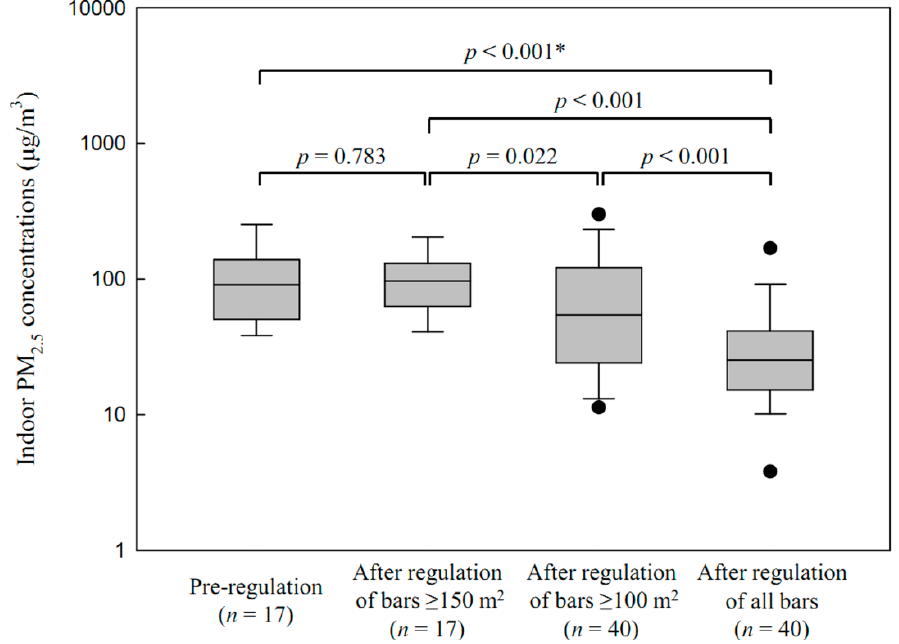
Figure 3. Distribution of indoor PM 2.5 concentrations in Seoul bars, pre-regulation, <100 m 2 , and after the regulation of bars ≥ 150 m 2 , bars ≥ 100 m 2 , and bars of all sizes. * Student’s t -test.